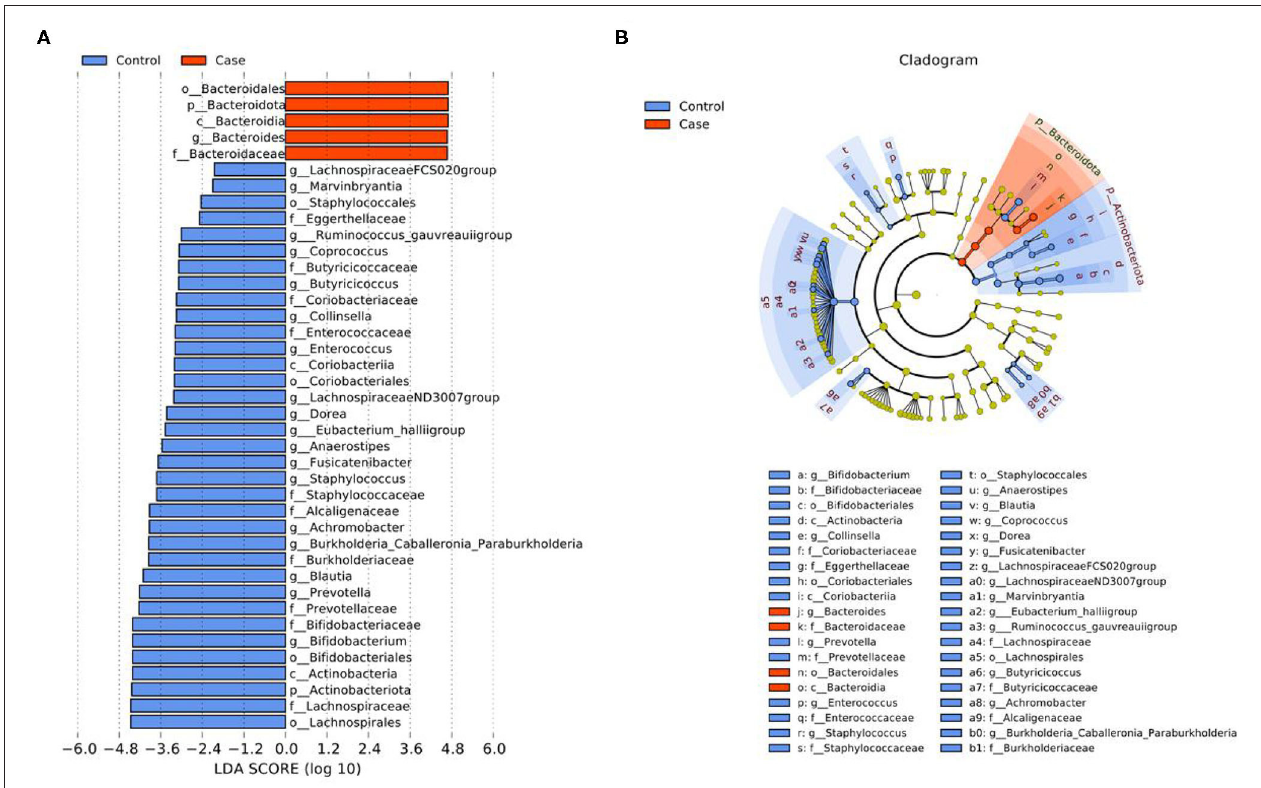
FIGURE 6 | LEfSe analysis of gut microbiota between the two groups. (A) LDA value distribution diagram. (B) Cladogram. p, Phylum; c, Class; o, Order; f, Family; g,